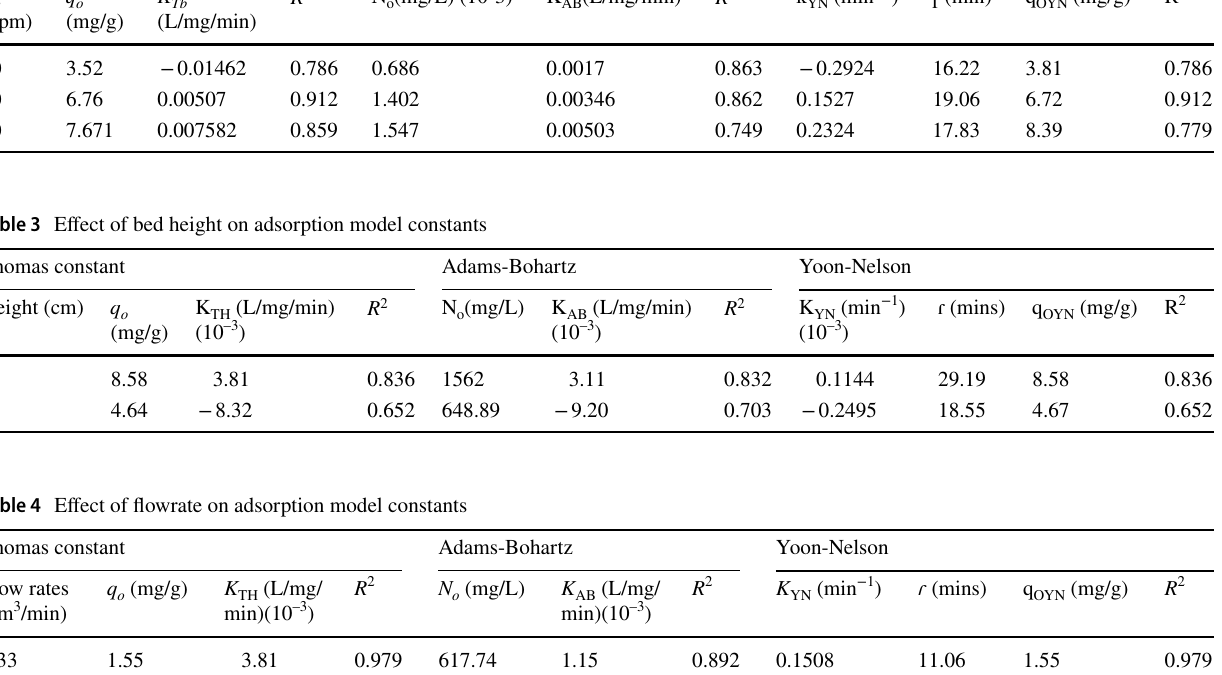
Table 2 Effect of initial amoxicillin concentration on adsorption model constants Thomas constant